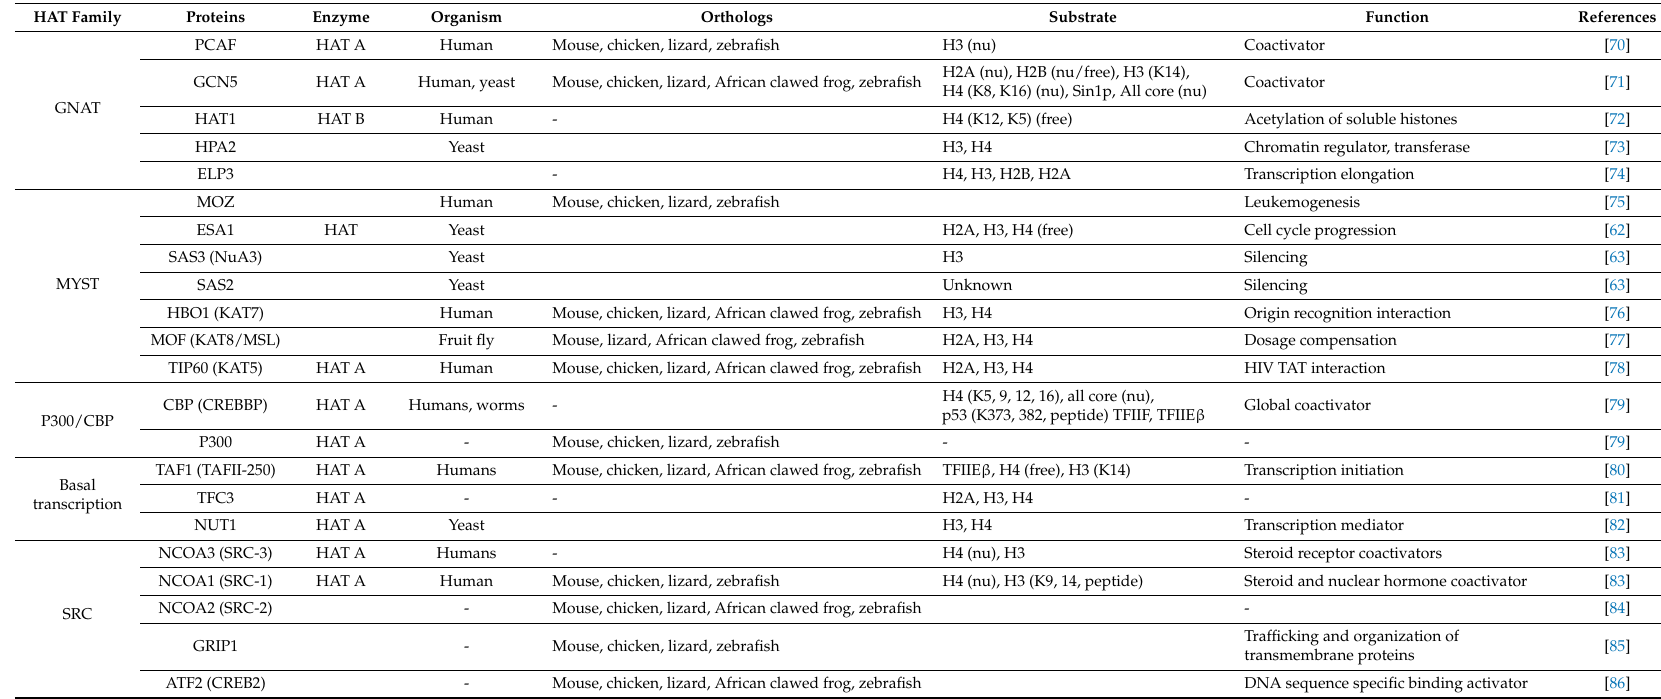
Table 2. HAT family members and their